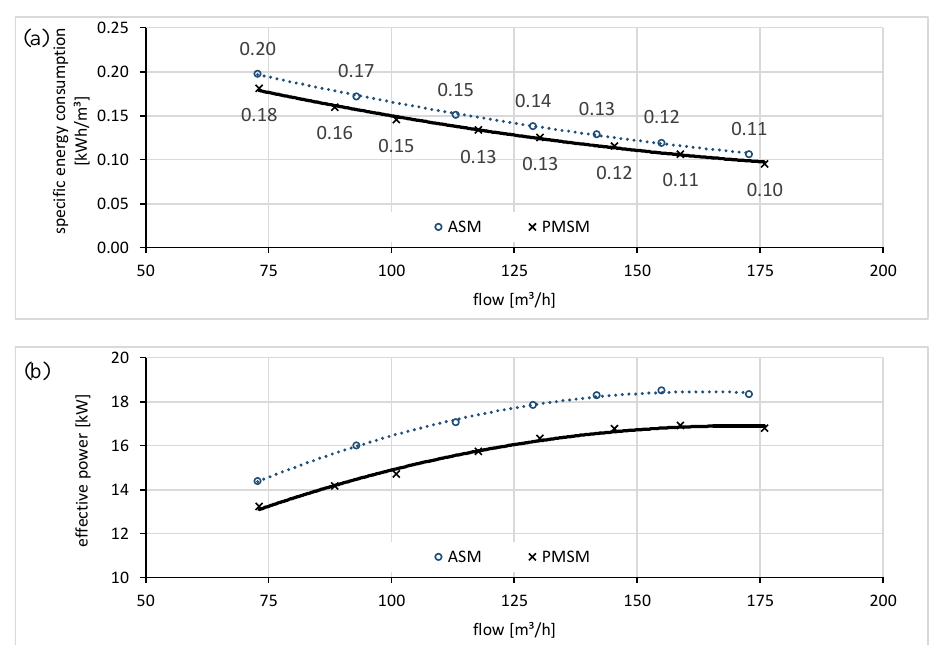
Figure 4. ( a ) Specific energy consumption and ( b ) effective power for the submersible ASM and PMSM pumps at 2900 rpm (close to the optimal working point). Table 1. Energy saving potential with global efficiency increase by the new PMSM well